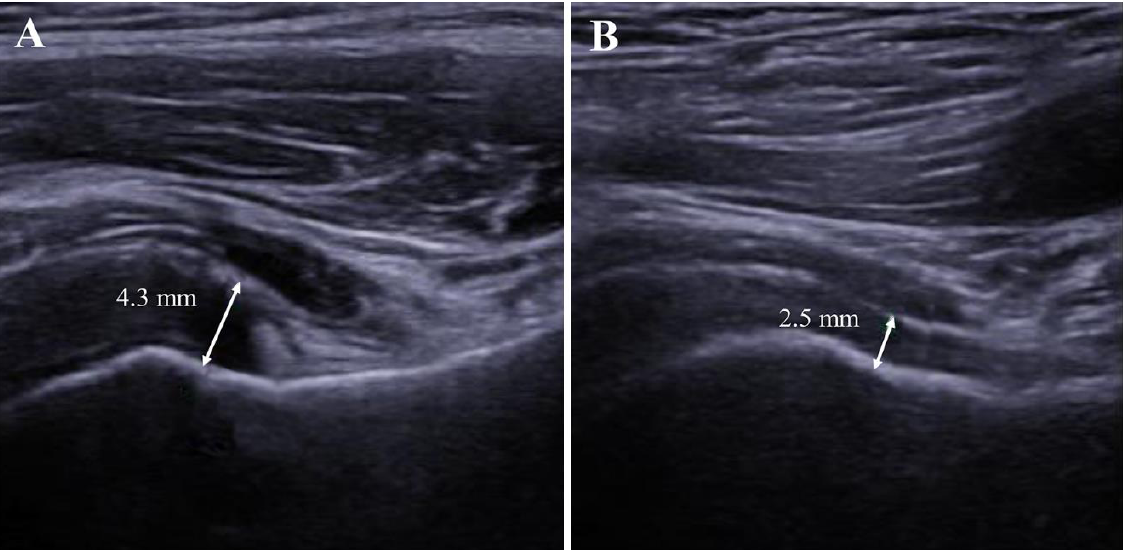
Figure 3. Follow-up evaluation of axillary recess in the affected shoulder. ( A ). Thickened axillary recess measured at 4.3 mm at the initial (baseline) visit. ( B ). Follow-up evaluation of the same patient showed a decreased thickness of the axillary recess after 6 months.